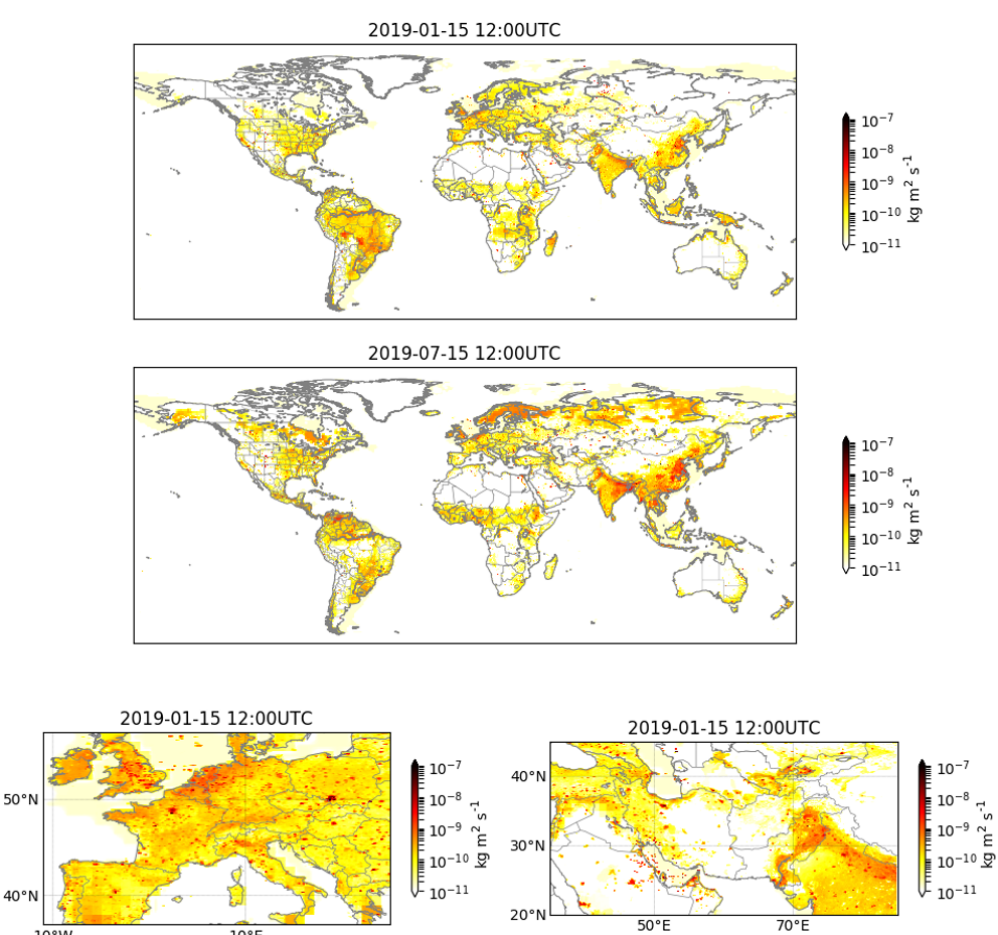
Figure 4. Examples of combined net fluxes (only positive values are shown due to the logarithmic scale) that constitute the surface boundary conditions of the IFS high-resolution CH 4 forecast. Global- and regional-scale examples for 15 January and 15 July 2019 at 12:00UTC are